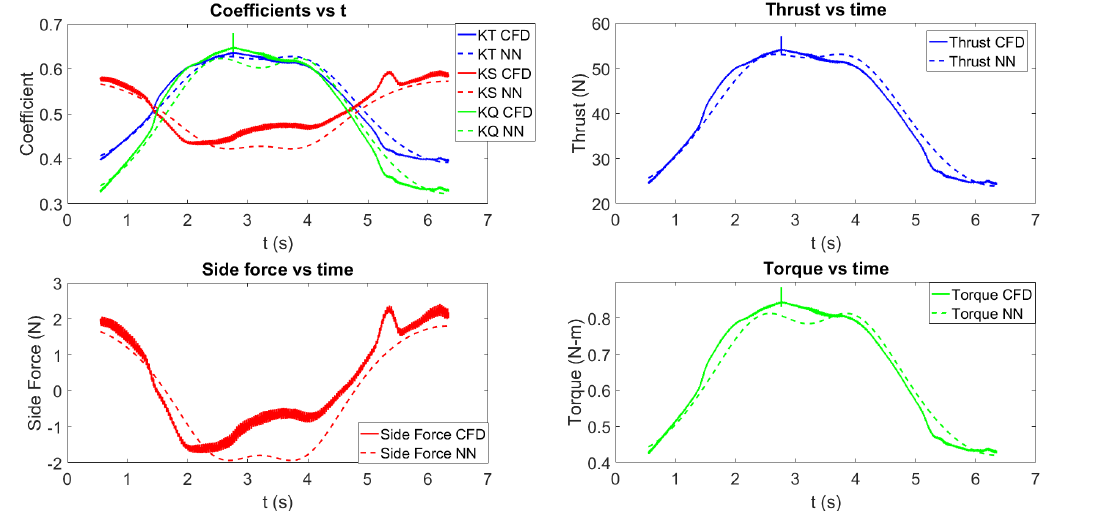
Figure 23. Behind condition coefficients, thrust, and torque for Test 3 as a function of time predicted by the neural